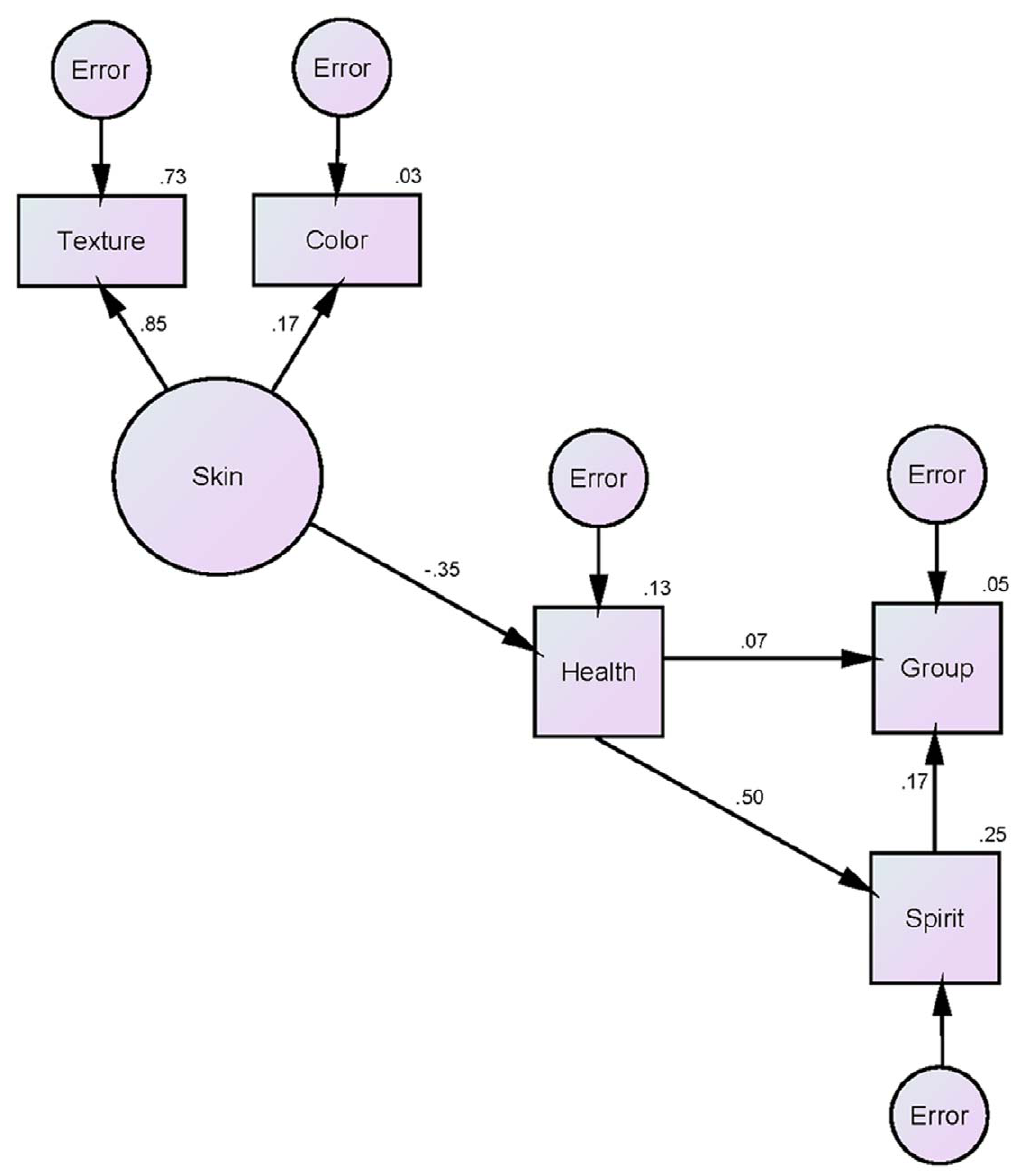
Figure 4. Trimmed structural equation model in which variables related to skin quality are tested as predictors of targets’ Mormon/ non-Mormon group membership and perceived spirituality by way of perceived health. Path coefficients are standardized ( b ’s), error variances for the endogenous variables are indicated in ovals, and variances explained (multiple R 2 values) are adjacent to the endogenous variables.